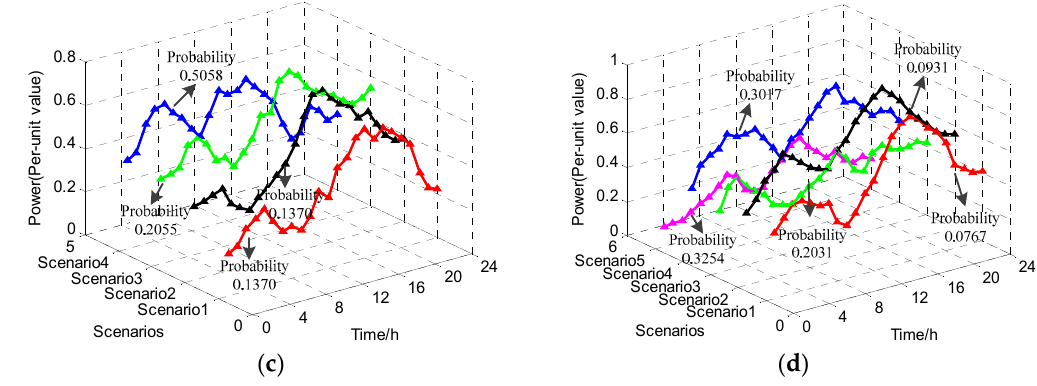
Figure 8. The scenario of wind power output for the four seasons: ( a ) The spring scenario of wind power output; ( b ) The summer scenario of wind power output; ( c ) The autumn scenario of wind power output; ( d ) The winter scenario of wind power output.